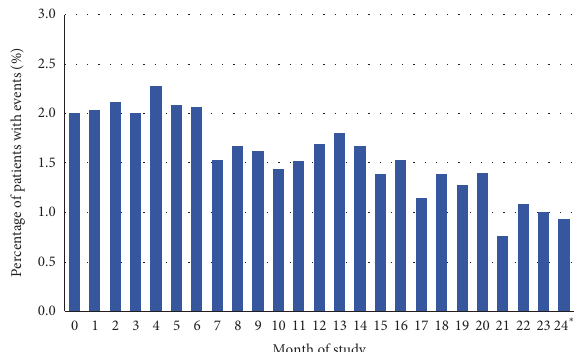
Figure 3: Overall incidence rates of adverse events starting at each month of the study. Calculation of percentages was based on number of patients not discontinued in the respective month. Patients with multiple adverse events within one month were counted only once. ∗ An additional 77 events occurred after the 24- month study period. As the incidence rates are calculated based on the number of nondiscontinued patients, it was not possible to calculate the incidence rate for the AEs occurring after study end.